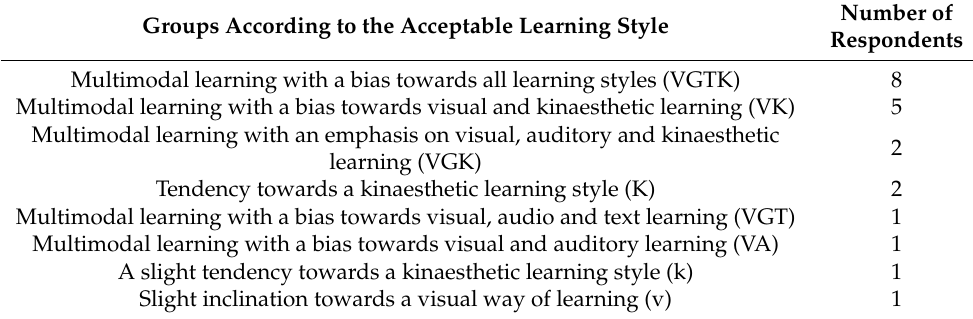
Table 1. Number of respondents in the groups according to the acceptable learning methods. Groups According to the Acceptable Learning